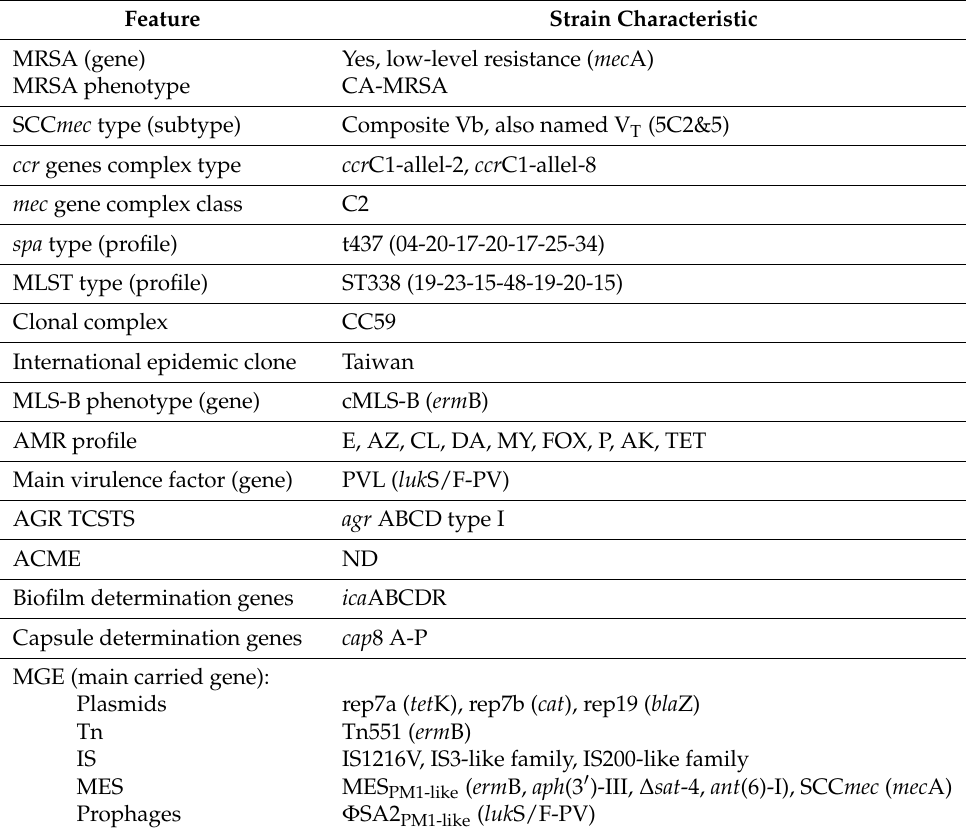
Table 1. Essential phenotype and genomic features of MRSA SO574/12 clinical isolate.